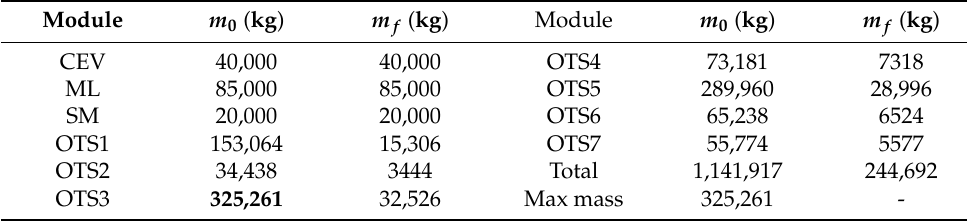
Table 12. Mass scale of